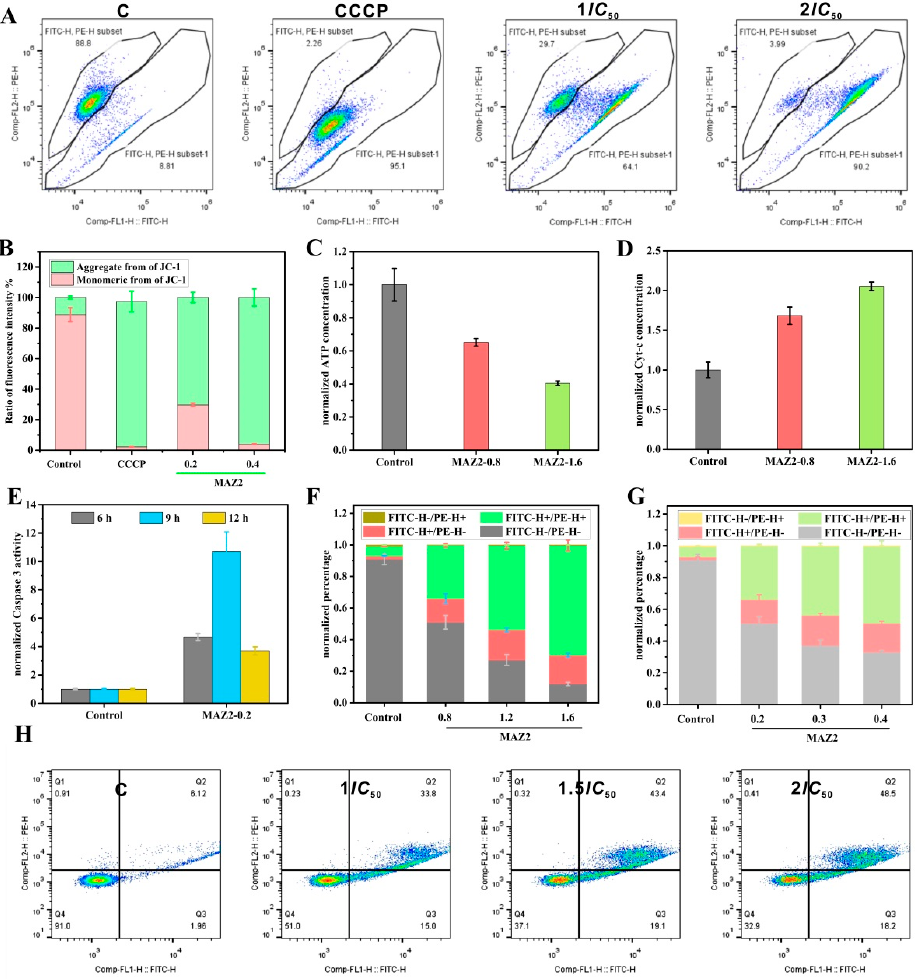
Figure 3. Apoptosis was induced by MAZ2 incubation; ( A ) is the membrane potential monitored by JC-1 staining; ( B ) is the ratio of aggregated JC-1 molecules to the monomeric molecules of ( A ); ( C ) is the ATP level; ( D ) is the cytosol’s cytochrome c content; ( E ) is the caspase 3 activity; ( F ) is the 4T1 cells’ apoptosis assay by flow cytometry; and ( G , H ) show the Molm-13 cells’ apoptosis assay by flow cytometry.